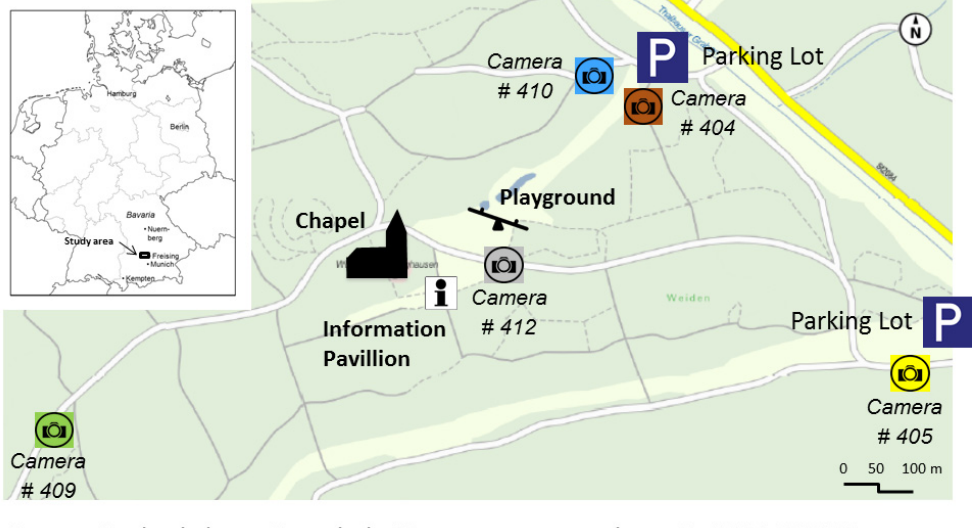
Figure 2. Map of the World Forest and monitoring sites west of Freising, Bavaria, Germany, with color codes for the cameras. For camera types related to the color codes, visitor monitoring questions, and data assessment procedures, see Appendix A, Table A1.